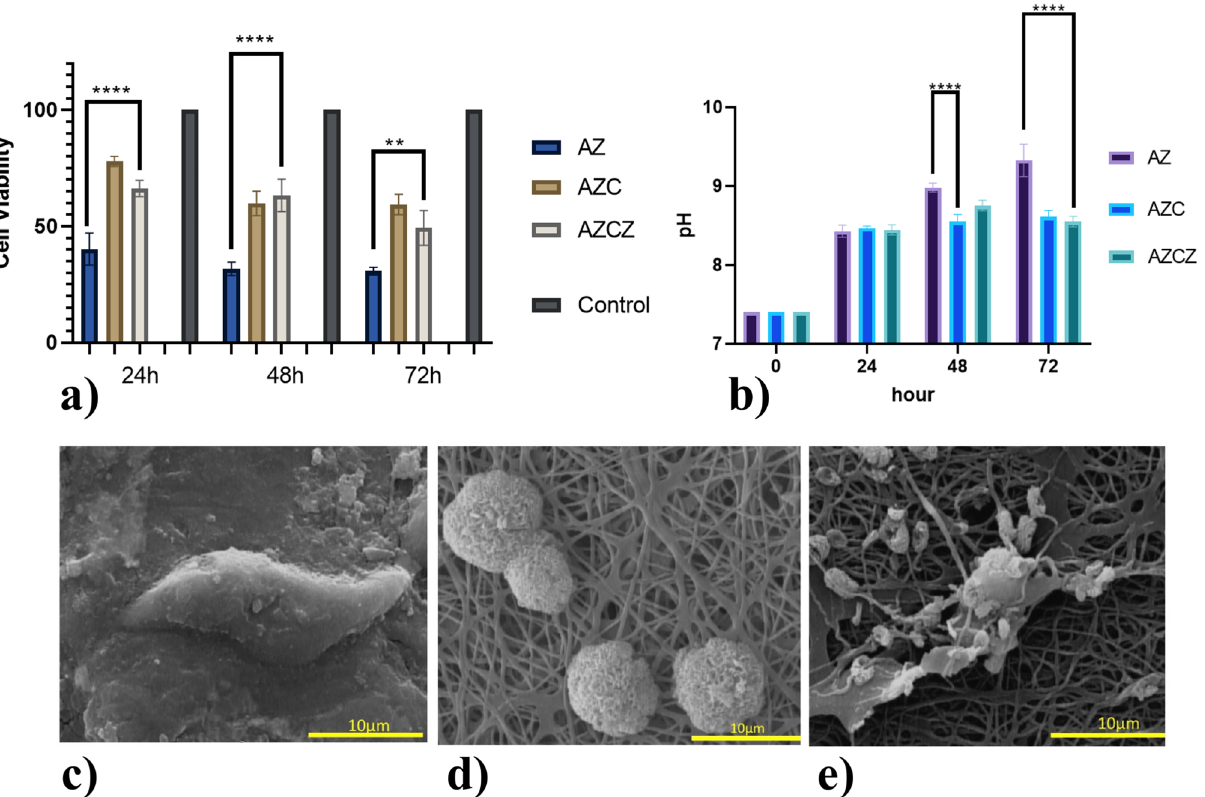
Figure 6. Effect of surface modification on the in vitro biocompatibility of AZ91 alloy. ( a ) MTT assay using fibroblast cells. ( b ) pH variation of AZ91 based implants after incubation in cell media. SEM images showing the adhesion and spreading of MG63 cells on the surface of ( c ) AZ, ( d ) AZC ( e )